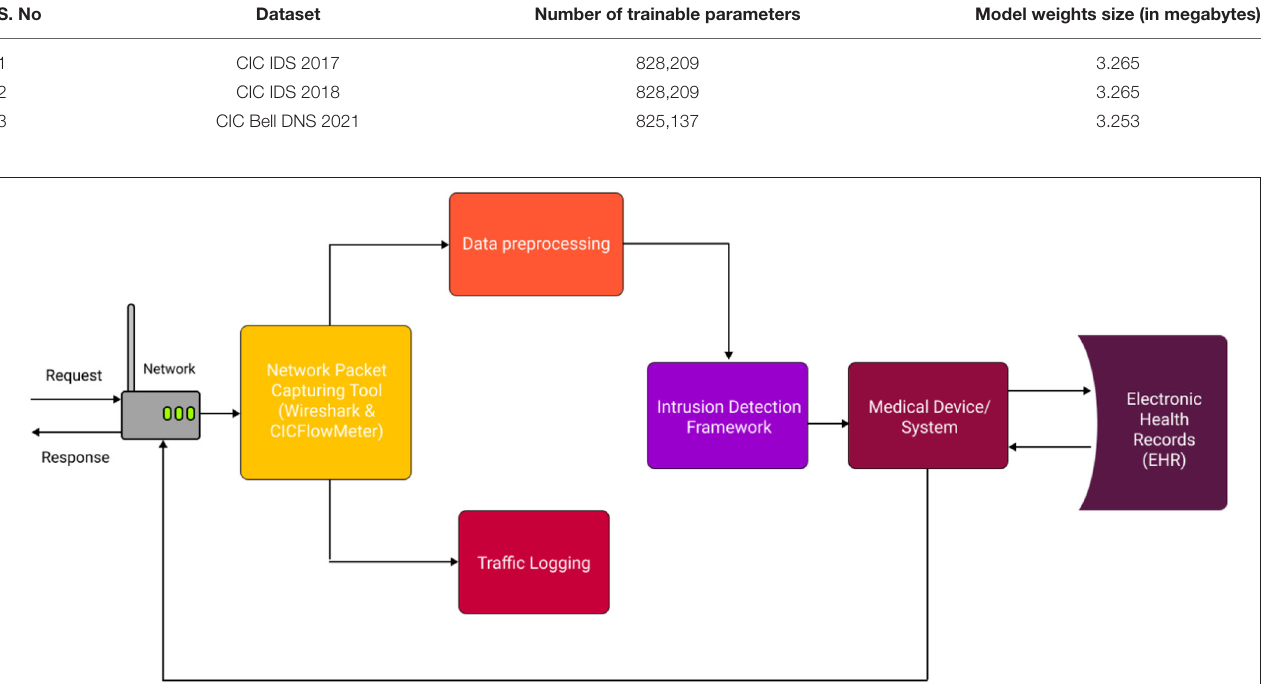
TABLE 11 | ImmuneNet’s model parameters and size for CIC IDS 2017–2018, and CIC Bell DNS 2021 datasets. S. No